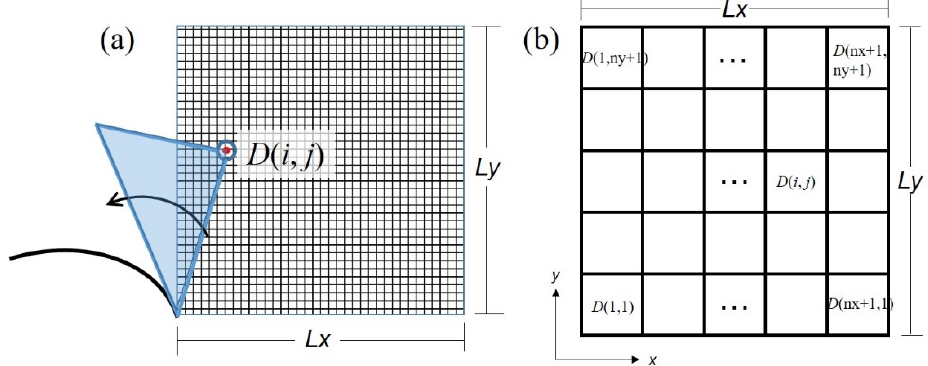
Figure 7. Three driving points at different positions for motion simulation. The initial position an- gles of α , ( a ) 0, ( b ) π /6, and ( c ) π /3.